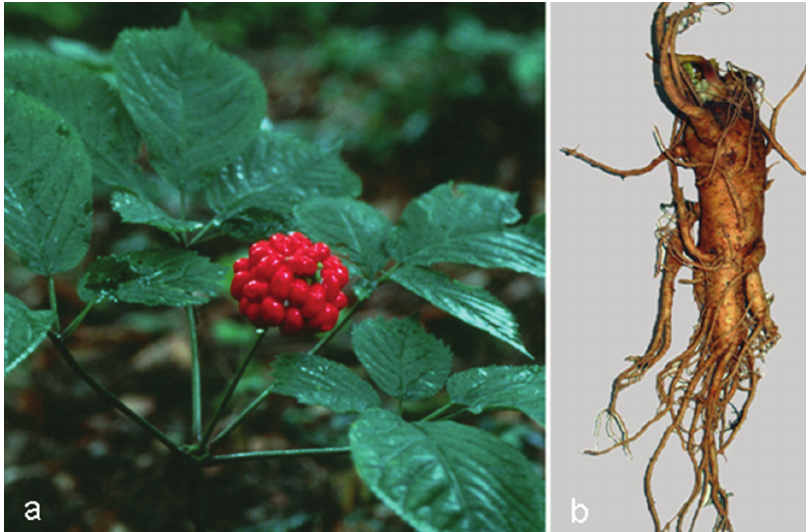
Figure 3. Panax ginseng C.A. Meyer: aerial parts (a) and root